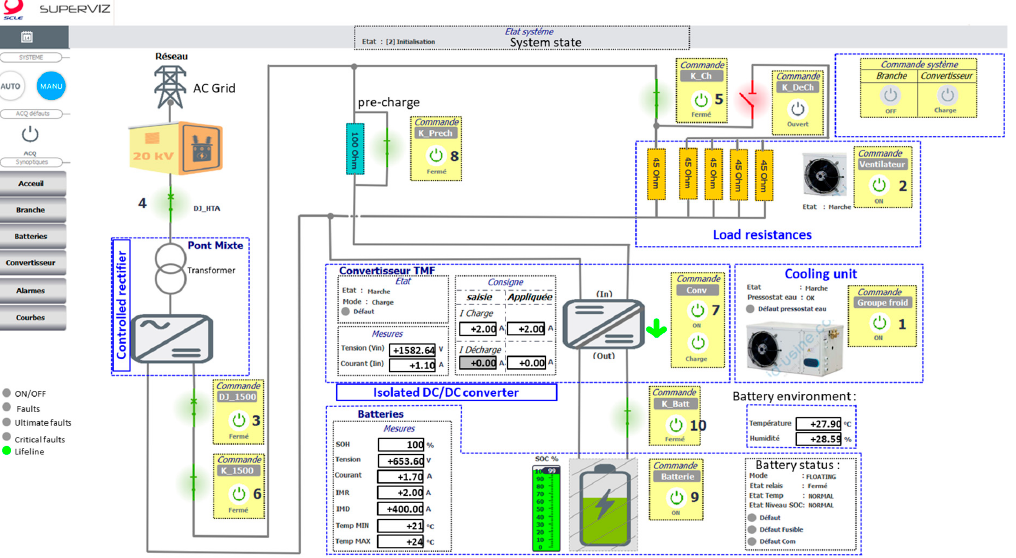
Figure 16. Human–machine interface (HMI) display developed especially for platform tests of the 300 kW/147 kWh elementary block prototype. 300 kW/147 kWh elementary block